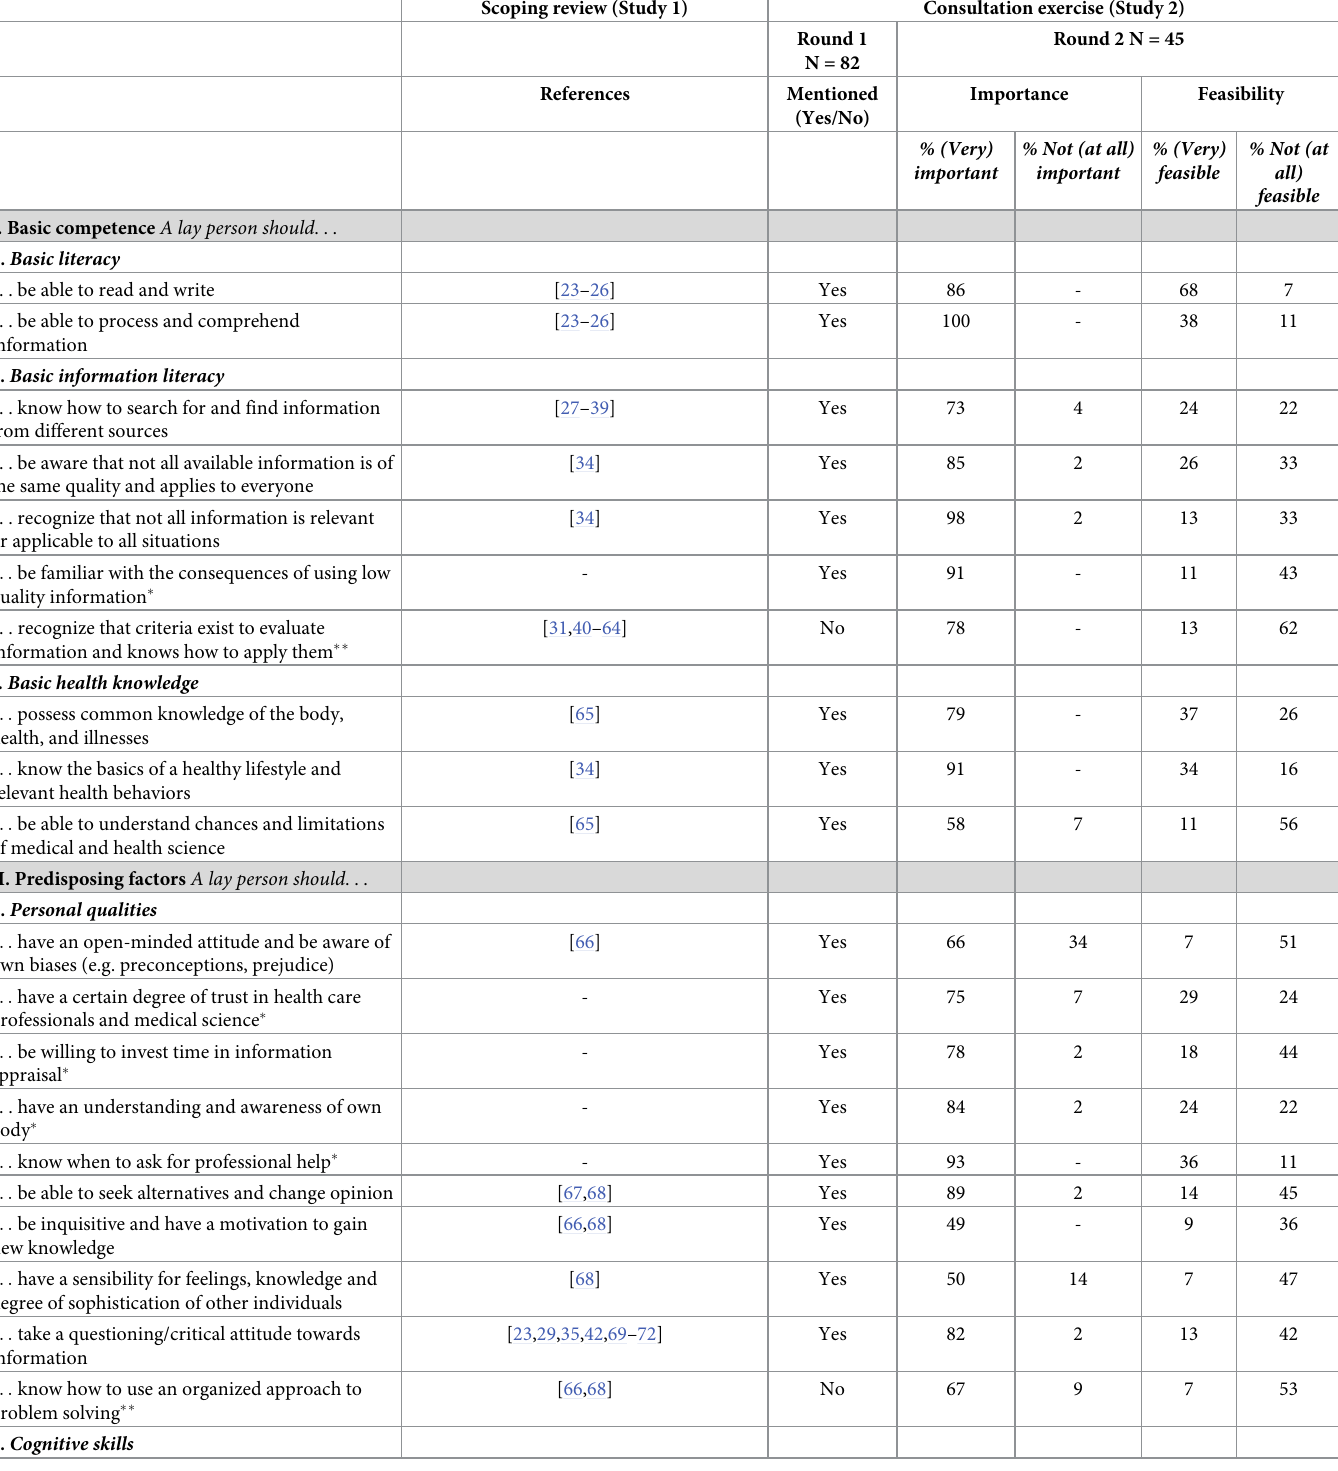
Table 1. Overview of skills, attitudes, or knowledge included in the operational definition of health information appraisal